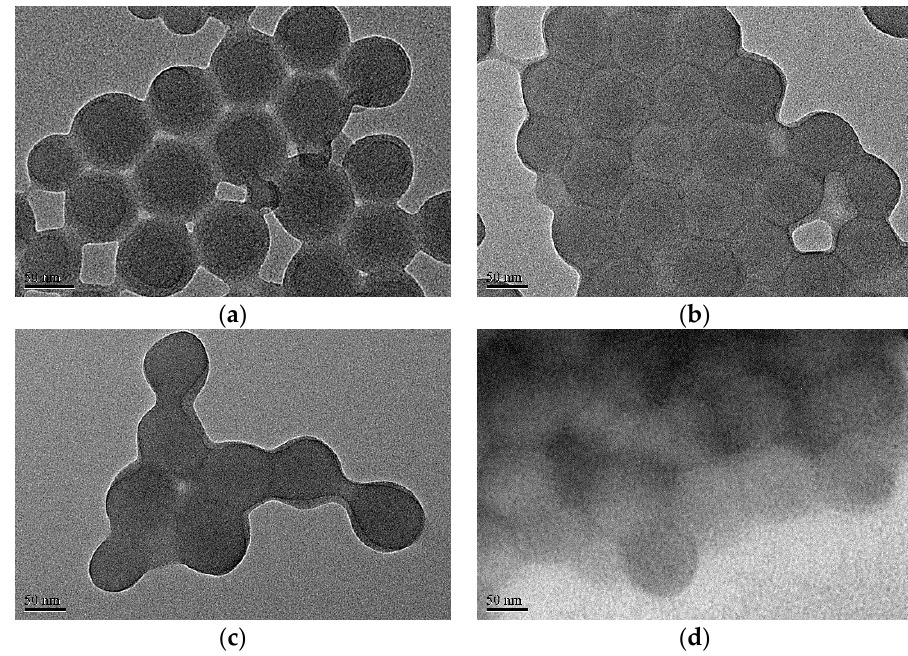
Figure 3. TEM images of ( a ) PS core; ( b ) SPB; ( c ) PAA-PAH double-layer modified SPB; and ( d ) PAA-PAH-PAsp triple-layer modified SPB.